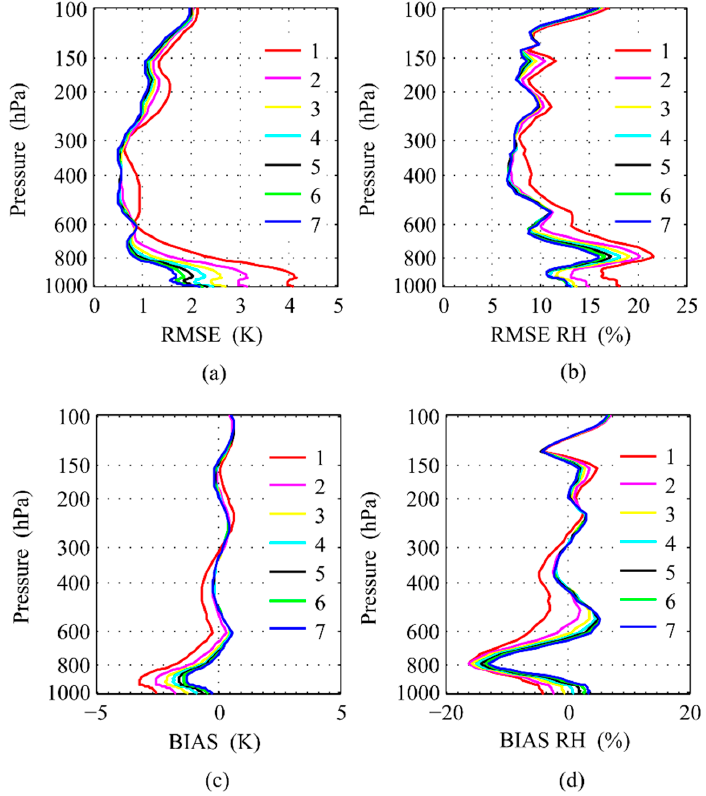
Figure 6. The retrieval result of FY-4B: ( a ) Temperature RMSE; ( b ) Humidity RMSE; ( c ) Temperature BIAS; ( d ) Humidity BIAS. Table 3. The errors of the seven retrievals.